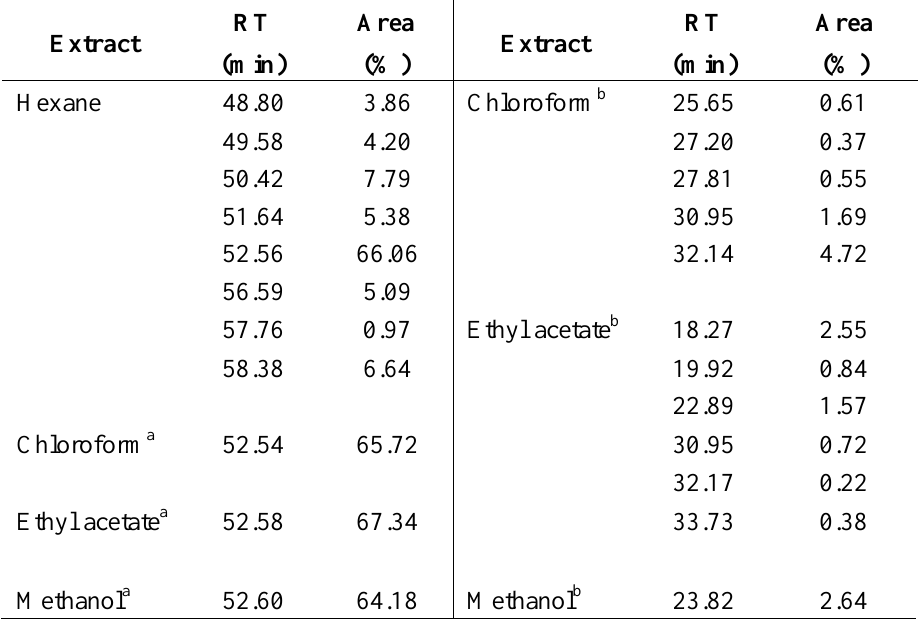
Table 1. Retention times and area peaks of plant